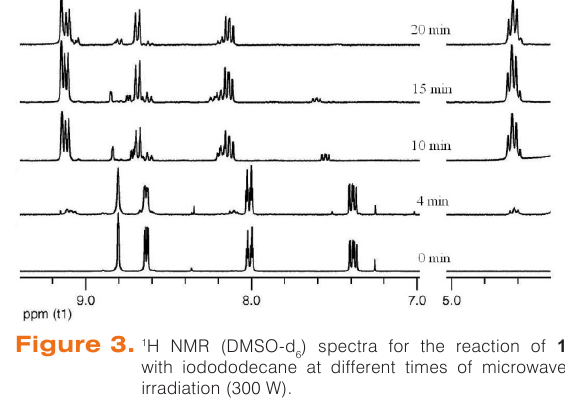
Figure 2. UV spectra of the adduct of 3-PBA (22 mg/l) with CH 1 M KCl; water, 25 0